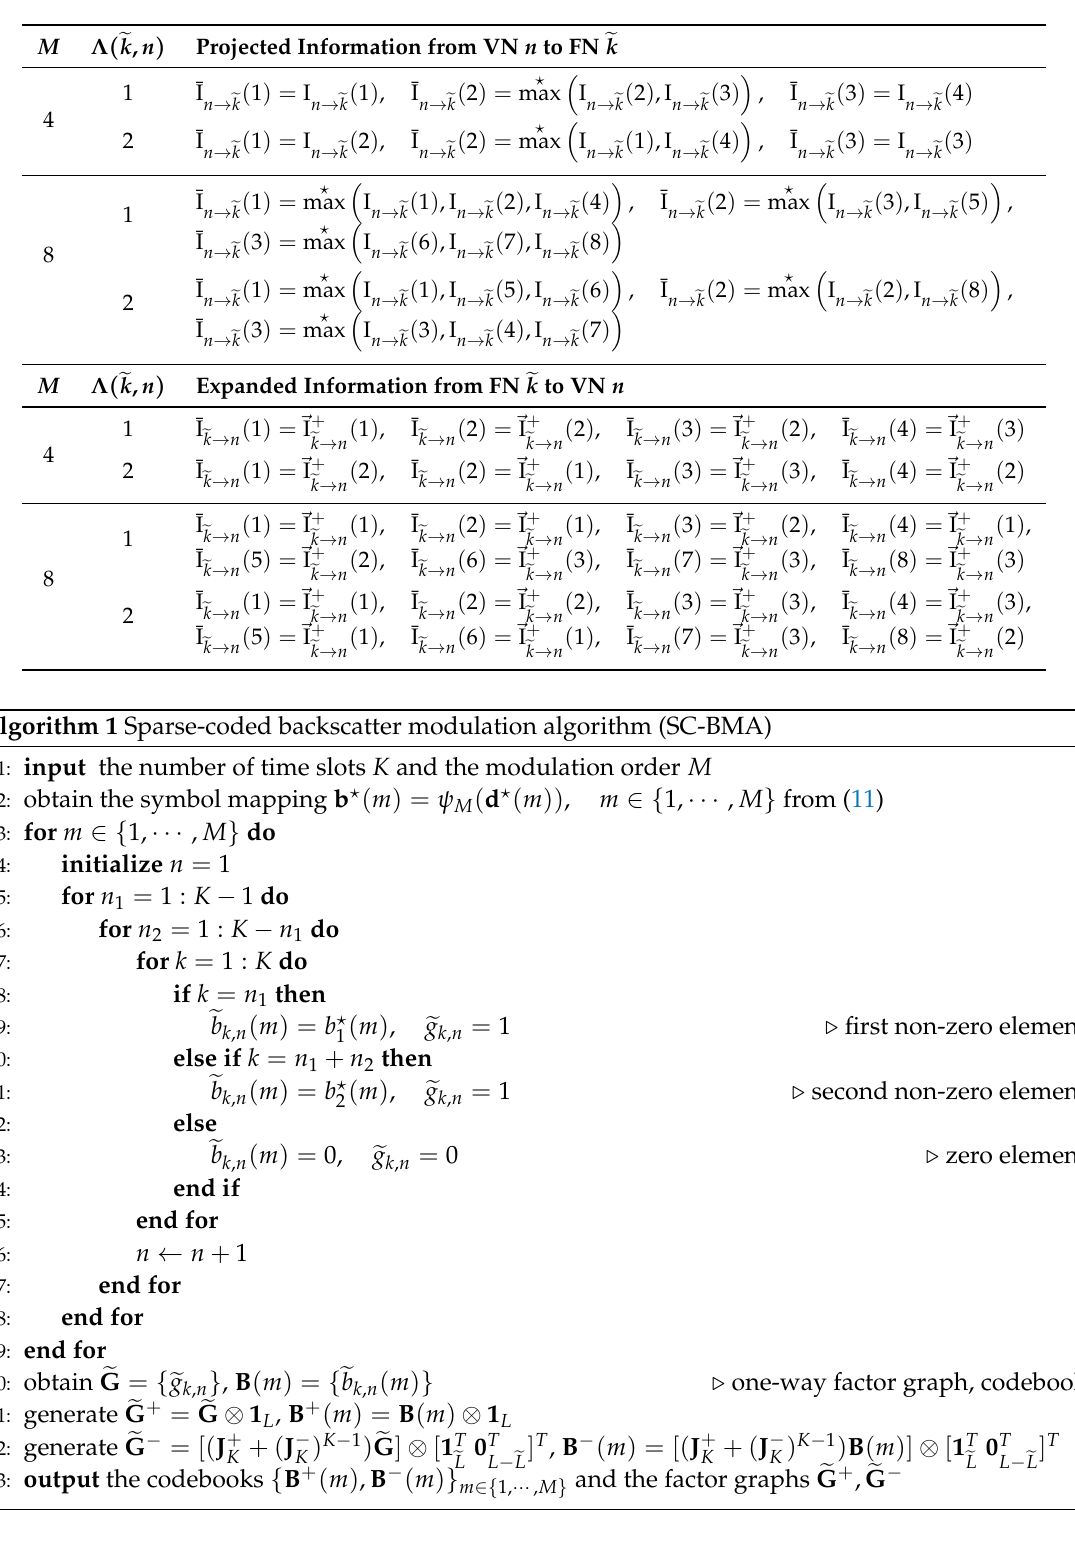
Table 1. Table of information projections and expansions (VN: variable node, FN: factor node).